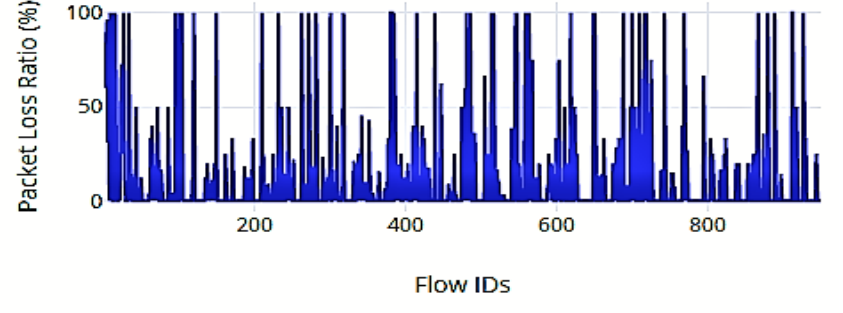
Figure 8. Packets Lost Ratio.